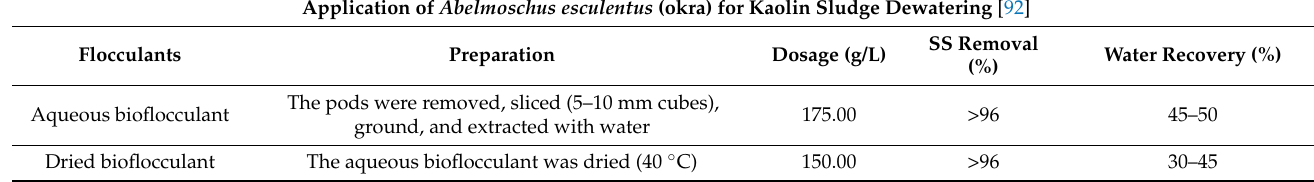
Table 2. Applications of plant-based flocculants for sludge